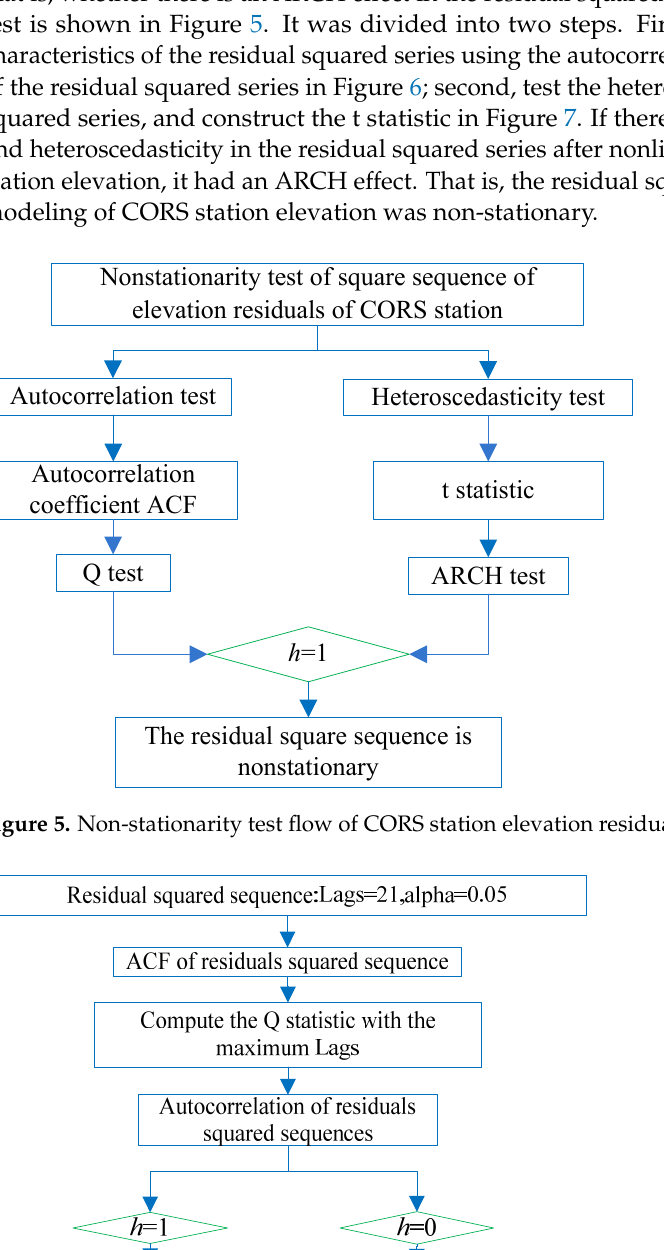
Figure 7. Heteroskedasticity ARCH test process. If both autocorrelation and heteroscedasticity existed in the residual square sequence after elevation nonlinear modeling of CORS, then it had an ARCH effect. That is, the re- sidual square sequence after elevation nonlinear modeling was non-stationarity. The Q statistic for the autocorrelation test is defined as follows: ρ = =